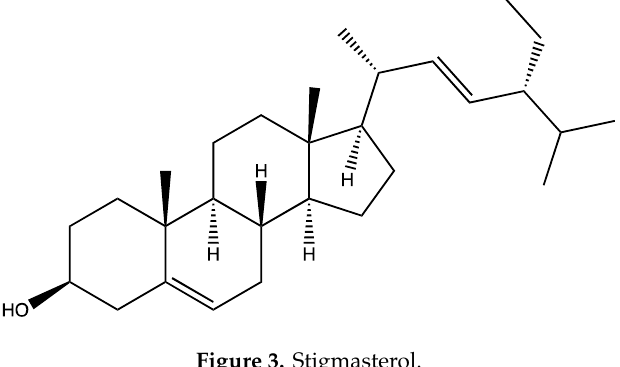
Figure 2. Major compounds of the essential oils (EOs) of Berberis vulgaris leaves and flowers. ( a ) p -cymene; ( b ) limonene; ( c ) ocimene.